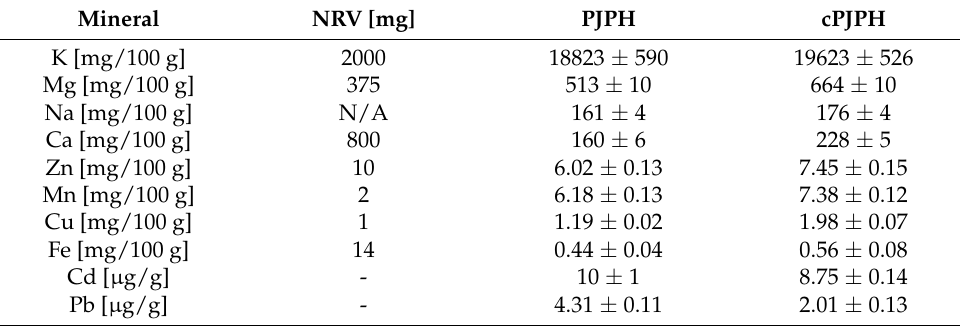
Table 2. Mineral composition of the analyzed